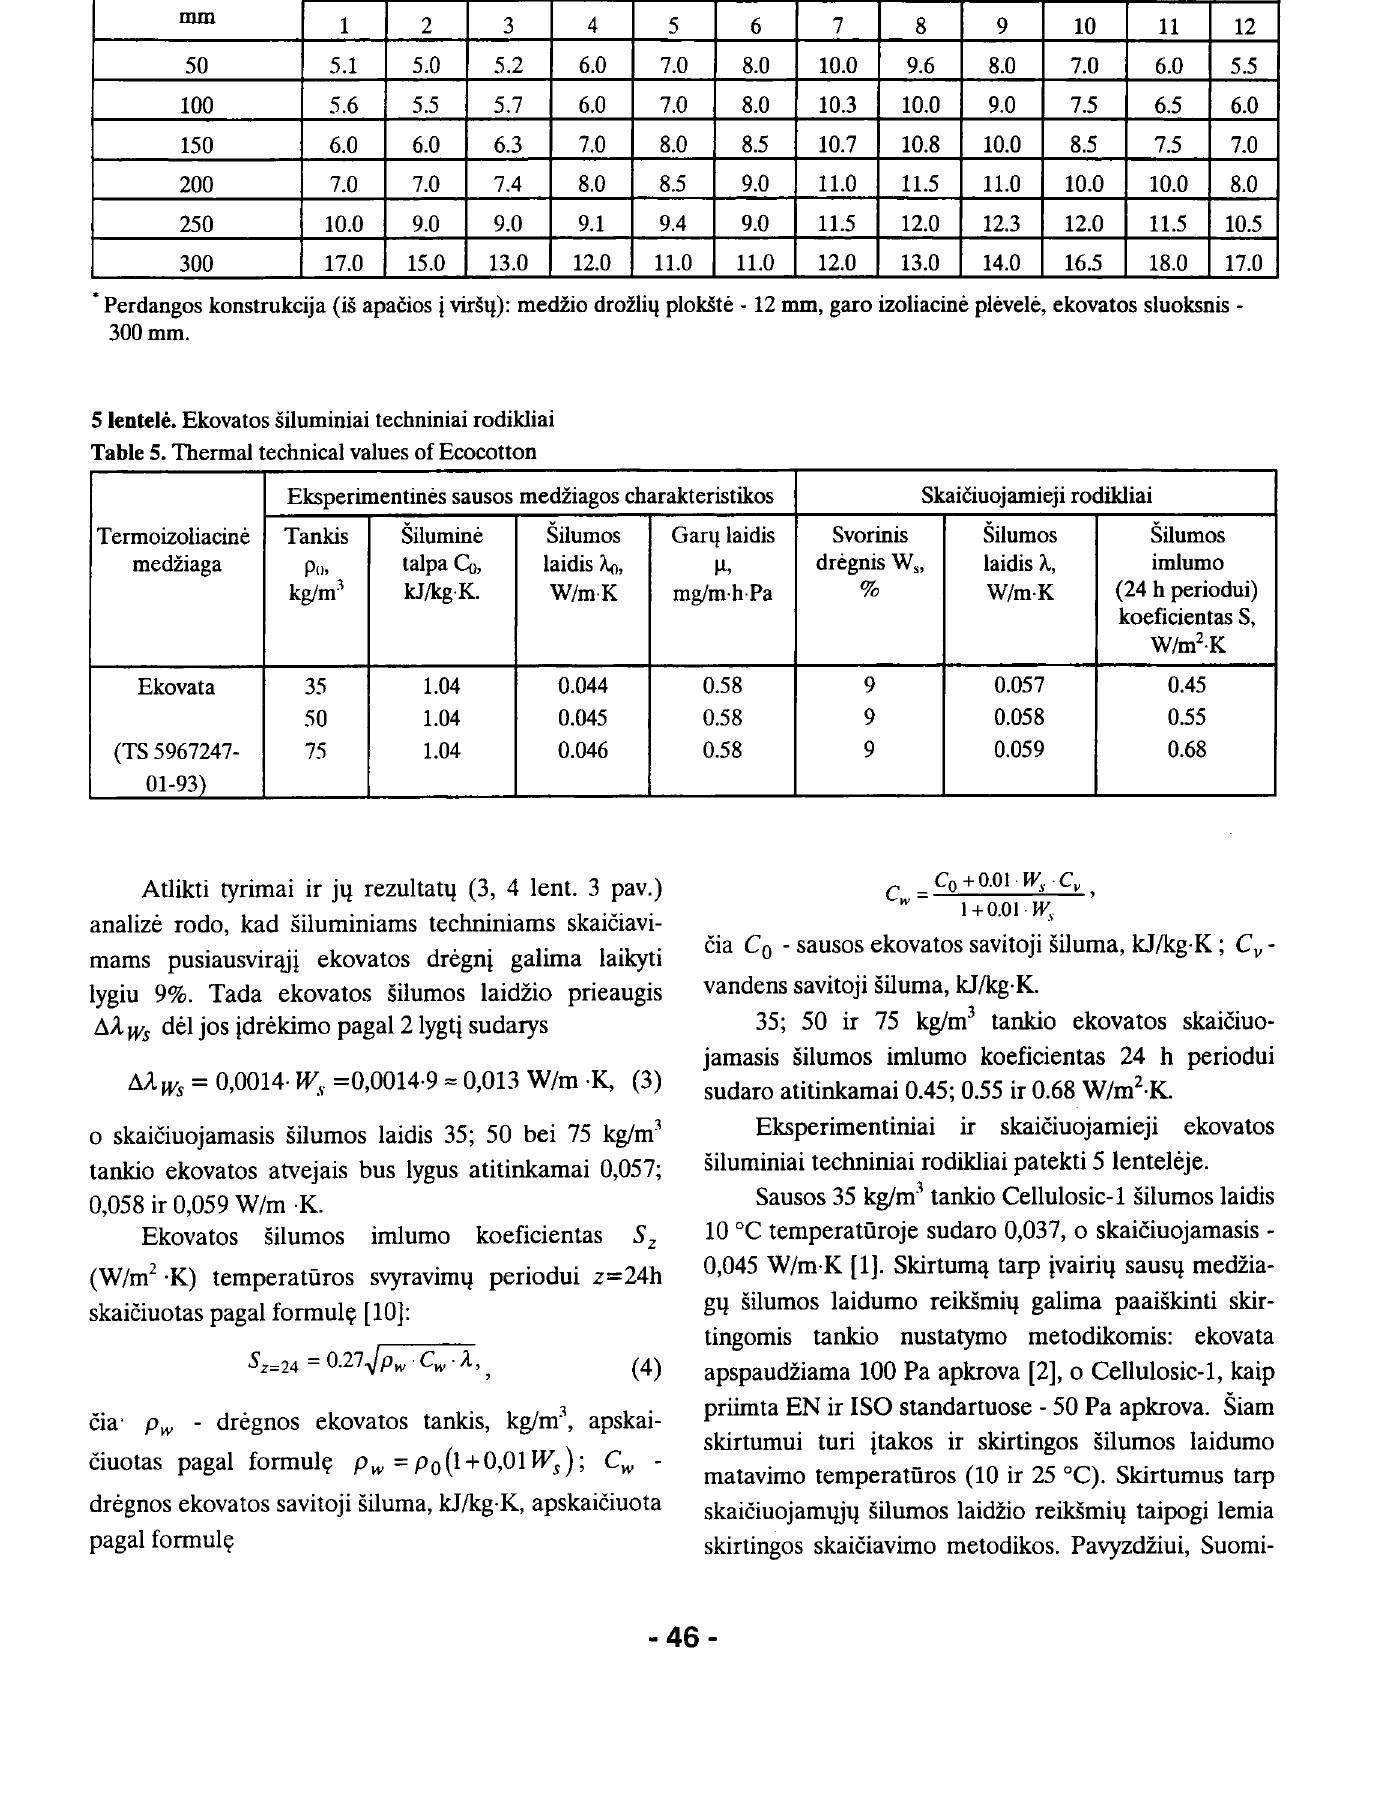
Table 5. Thermal technical values of Ecocotton Eksperimentines sausos medziagos charakteristikos Skaiciuojamieji rodikliai Termoizoliacine Tankis Silumine Silumos medziaga Po, talpa Co, laidis